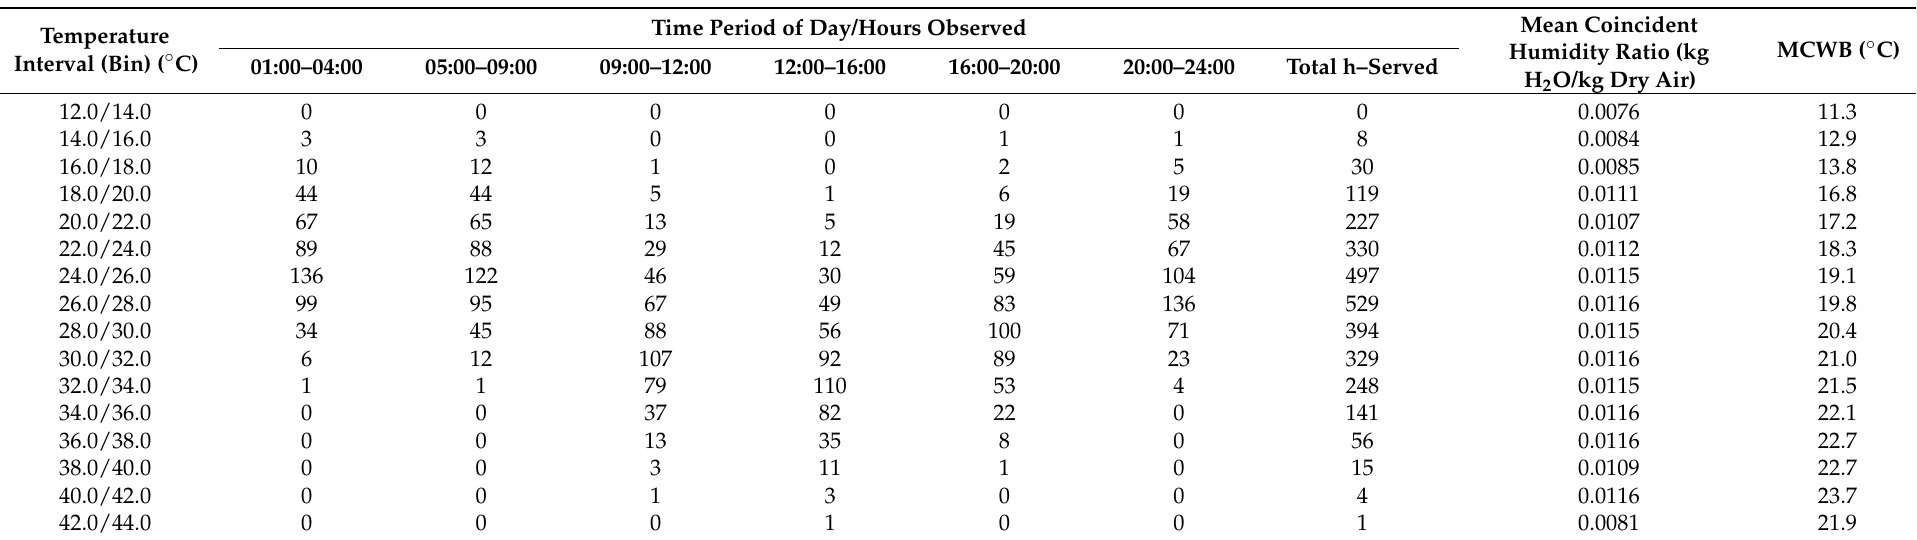
Table 2. Bin data for Athens (NOA). Cooling season (June to September)—Period